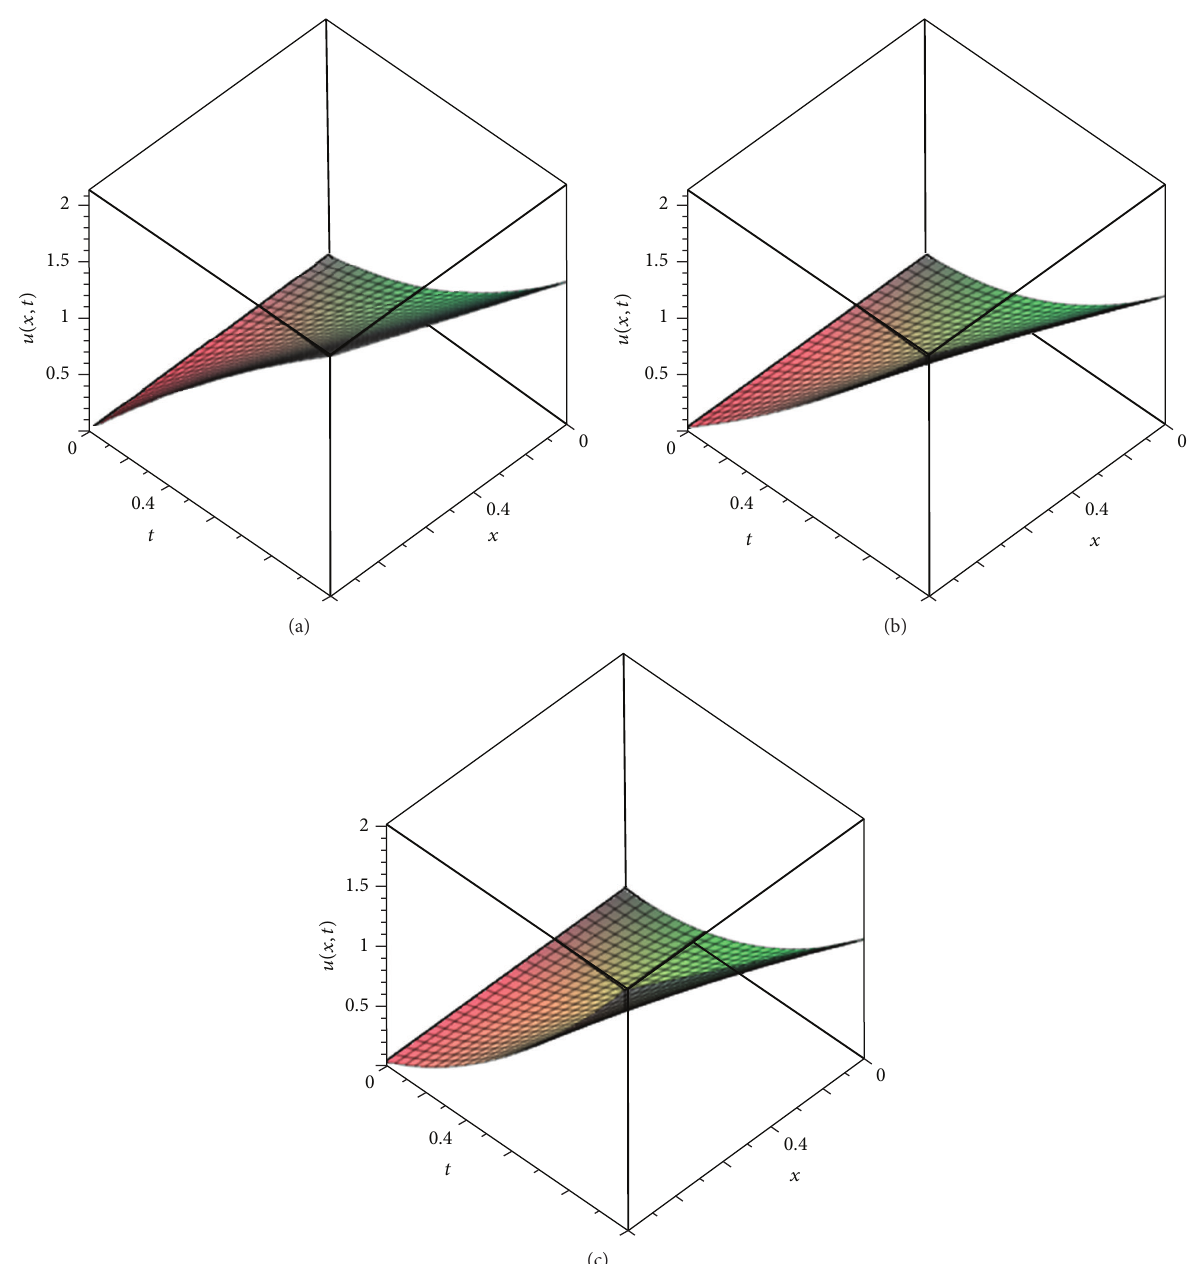
Figure 7: Plot of 𝑢(𝑥,𝑡) with respect to 𝑥 and 𝑡 at (a) 𝛼 = 0.5 , (b) 𝛼 = 0.75 , and (c) 𝛼 = 1